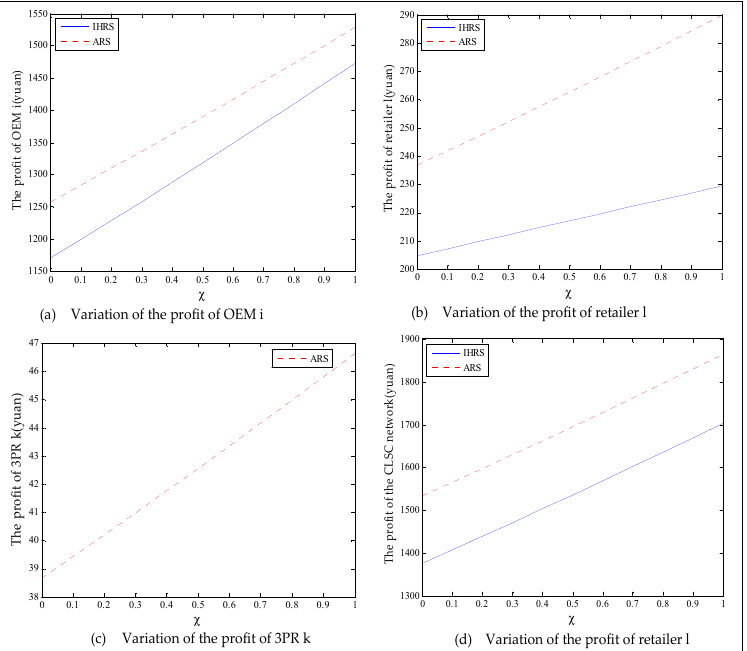
Figure 16. Changes of the costs of carbon emission and the patent licensing fee in Case 2 of Section 6.2.